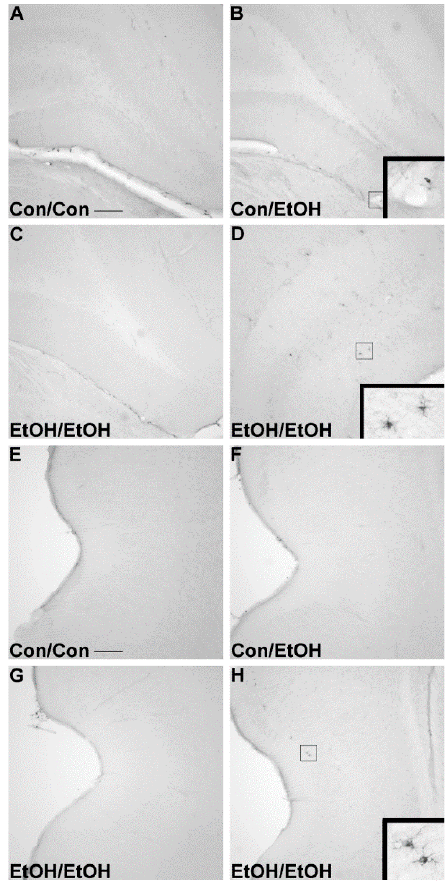
Figure 4. Lack of OX-6 Positive Cells. No OX-6 positive cells were observed regardless of treatment, except in one EtOH/EtOH rat as shown in representative photomicrographs of the ( A – C ) hippocampus or ( E – H ) entorhinal cortex in ( A , E ) controls, ( B , F ) Con/EtOH ( C , G ) or EtOH/EtOH groups. OX-6 positive cells could be seen along blood vessels as shown in the inset of B. One EtOH/EtOH animal showed upregulation of OX-6 in both the ( D ) hippocampus and ( H ) entorhinal cortex. Scale bars = 200 µm.